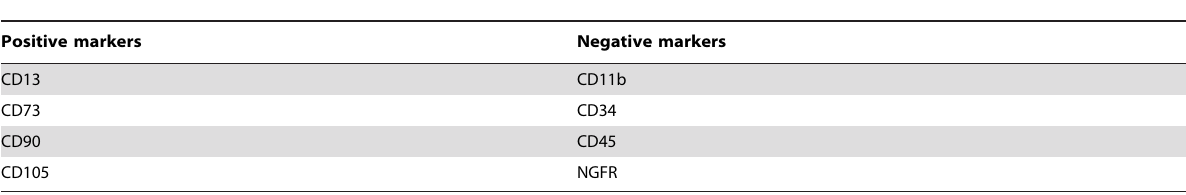
Table 1. Summary of the flow cytometry analysis of UCM-MSCs.